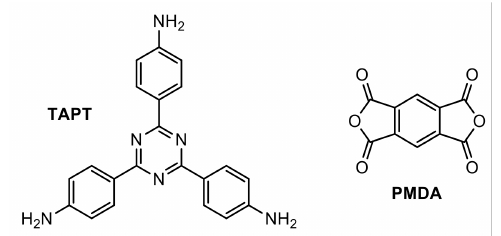
Figure 7. Structures of CS-COF-1 building